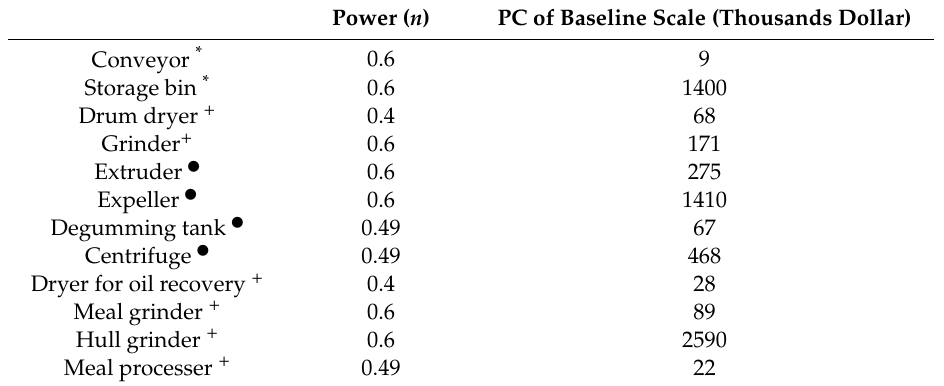
Table 2. Facility prices and power values (n from Equation (2)) used for PC estimation for various processing capacities (baseline of 2015 price). Power ( n ) PC of Baseline Scale (Thousands Dollar)